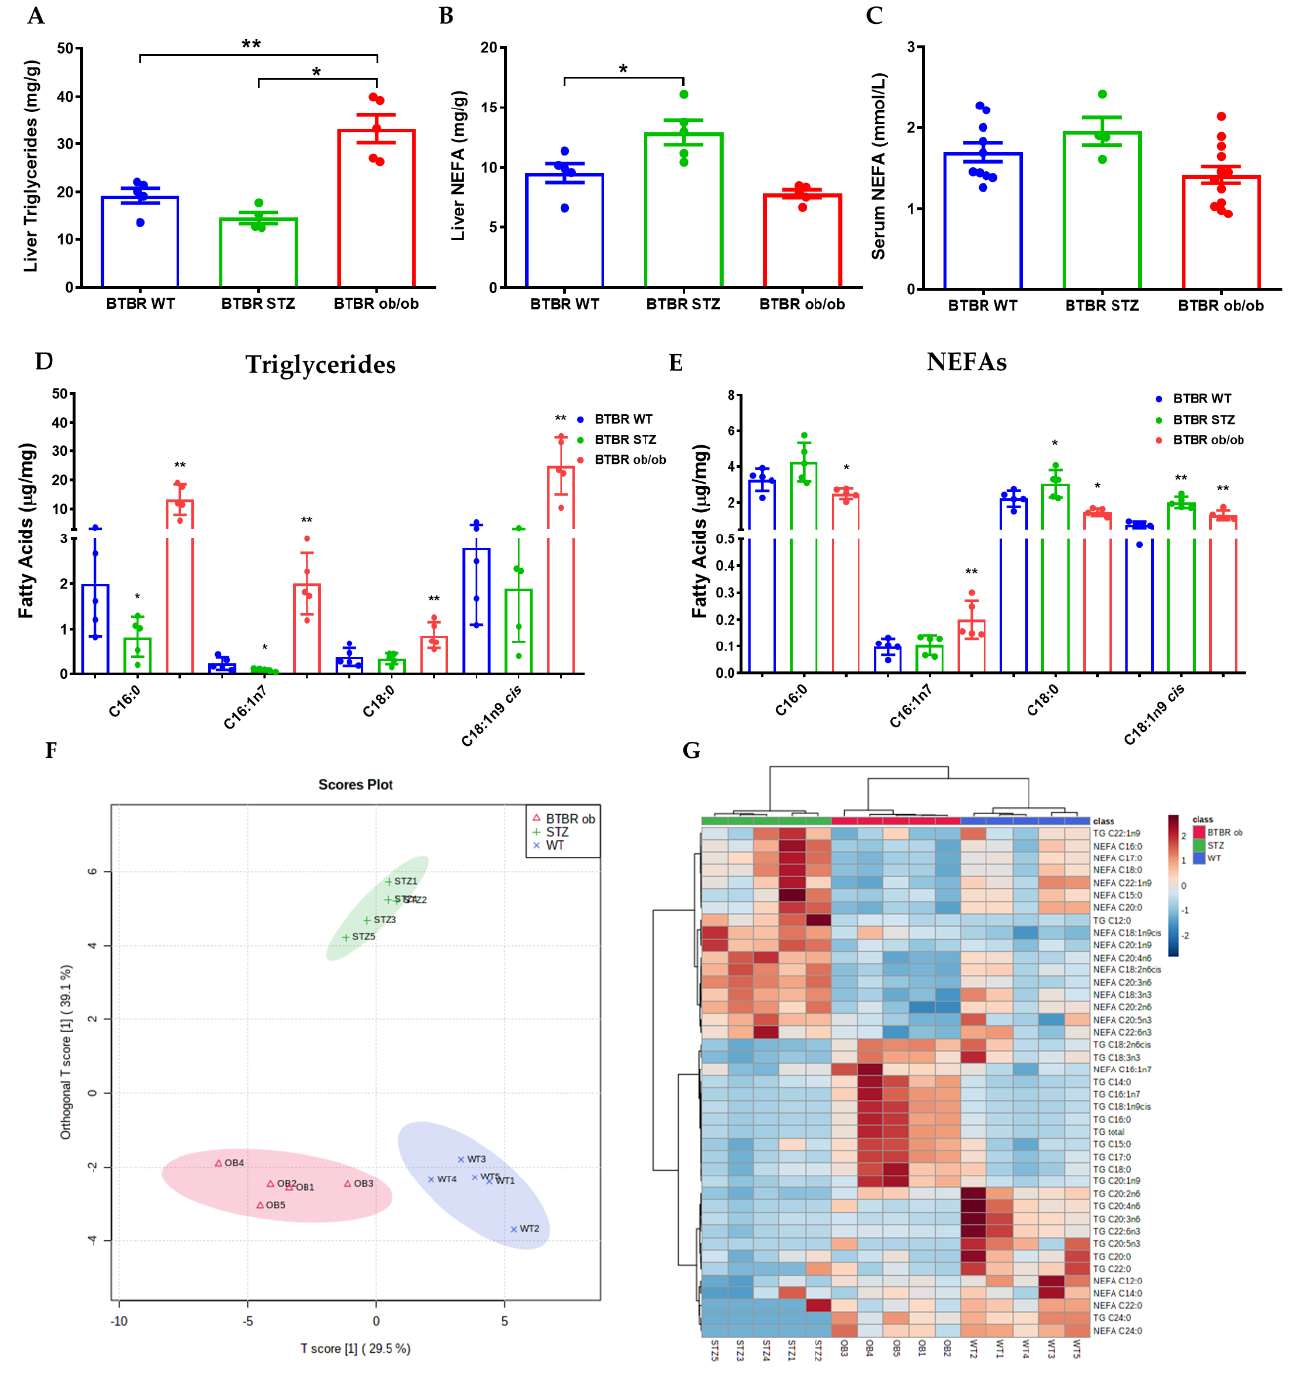
Figure 5. Lipid composition in liver at 22 weeks from BTBR WT (blue), BTBR − STZ (green) and BTBR ob/ob mice (red). Measurement of liver TGs ( A ), liver NEFAs ( B ) and serum NEFAs ( C ). Analysis by GC − MS of fatty acids, involved in de novo lipogenesis, from triglycerides ( D ) and NEFAs ( E ). ( F ) Orthogonal Partial Least Squares Discriminant Analysis (oPLS − DA) based on liver lipid composition data showing a clear separation between models. ( G ) Hierarchical clustering based on liver lipid composition showing the upregulated lipids (dark brown) and downregulated (dark blue) in each experimental group. Data are shown as scatter dot plots and mean ± SEM of each group ( n = 5–8 mice/group); * p < 0.05, ** p < 0.01 vs. BTBR WT or BTBR − STZ.